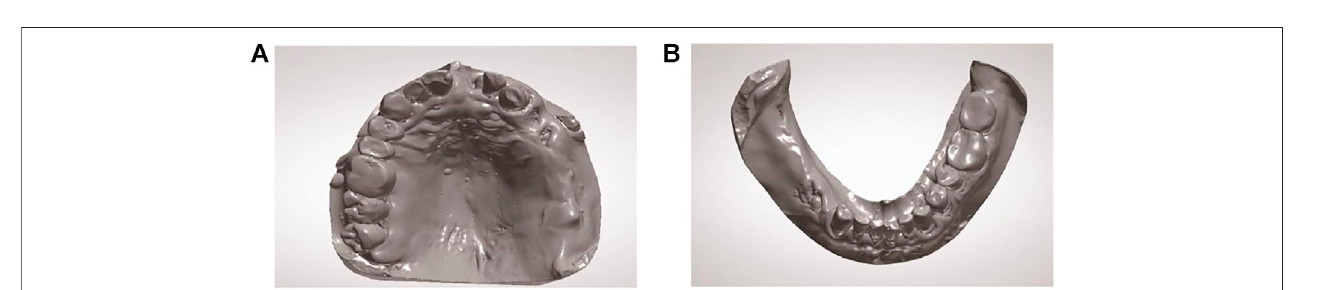
FIGURE 2 | Intraoral scans of the patient ’ s arches. (A) Maxillary STL occlusal view. (B) Mandibular STL occlusal